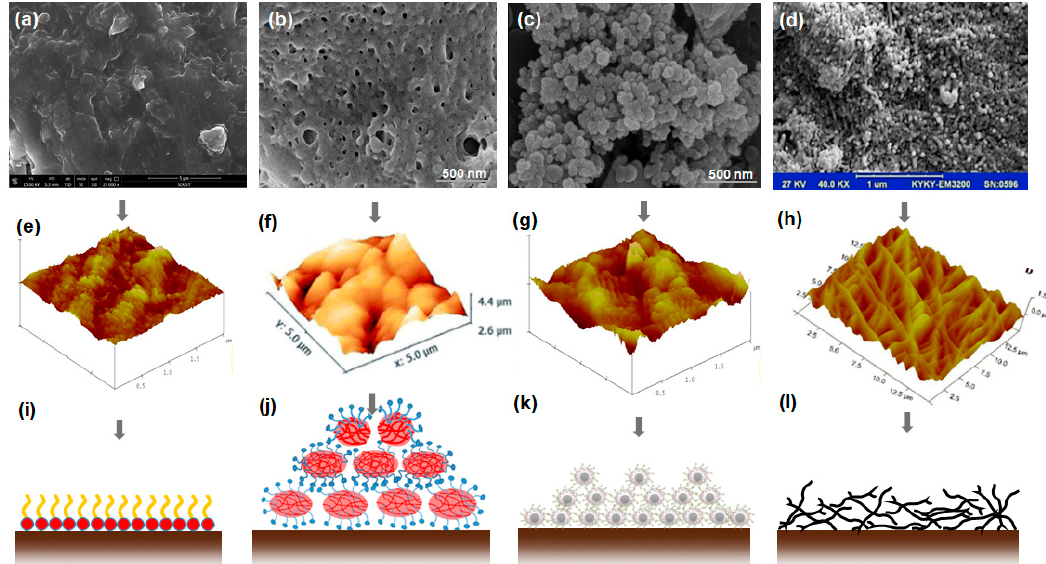
Figure 6. Morphology and adsorption of fluorochemicals with varying structures: ( a ) fluorosurfactant